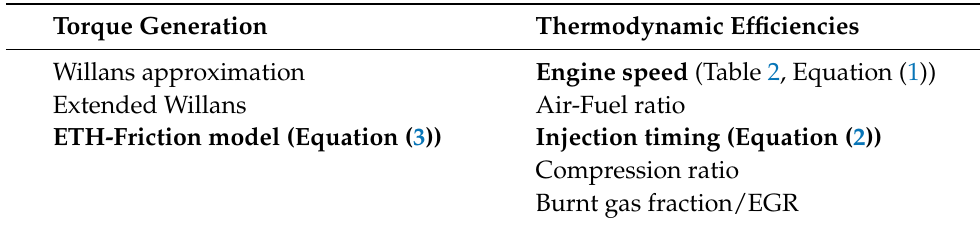
Table 1. Original structure of calculation method and submodels in Section 2.5 (Mechanical systems) of [26]. Bolded submodels are used in this